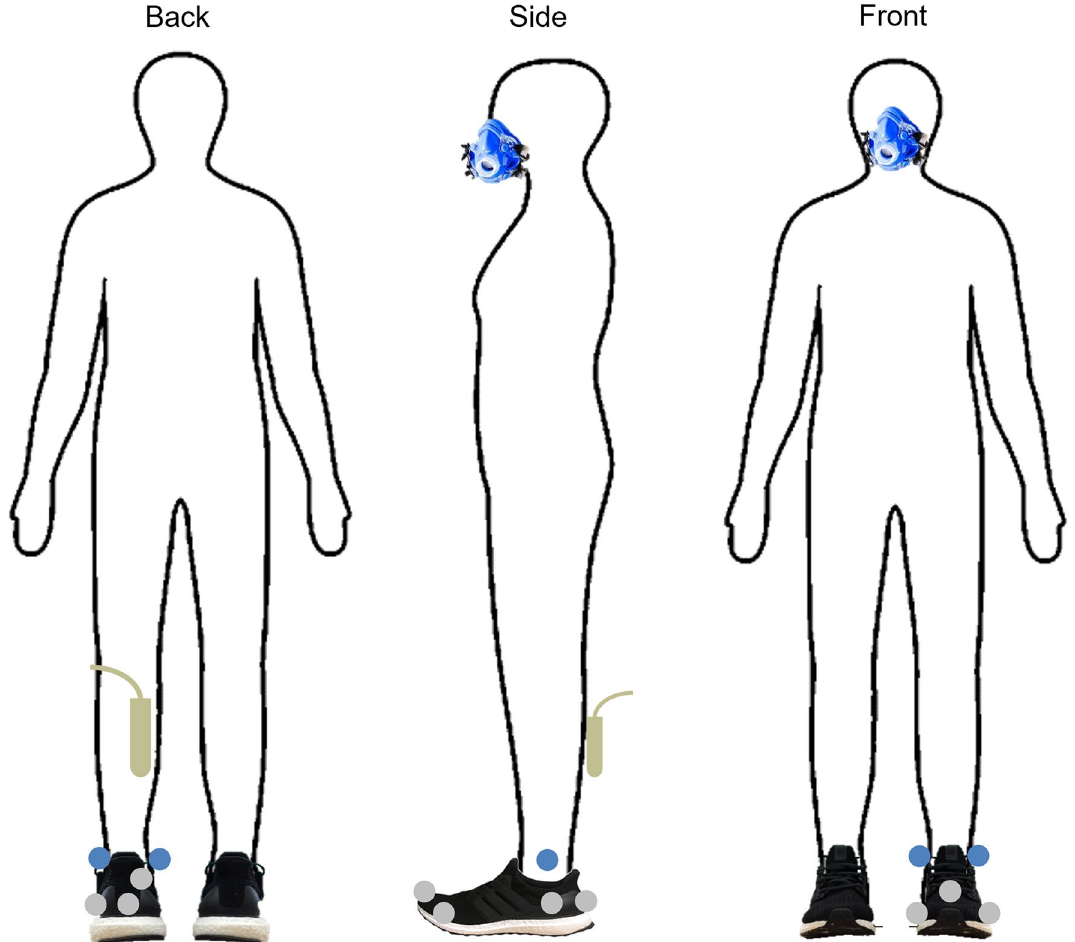
Figure 4. Schematic views of the back (left), side (middle) and front (right) view of the participant with all equipment attached during the running trials (motion capture markers, ultrasound probe and breathing mask). The grey markers remained on while the blue markers were removed during the running